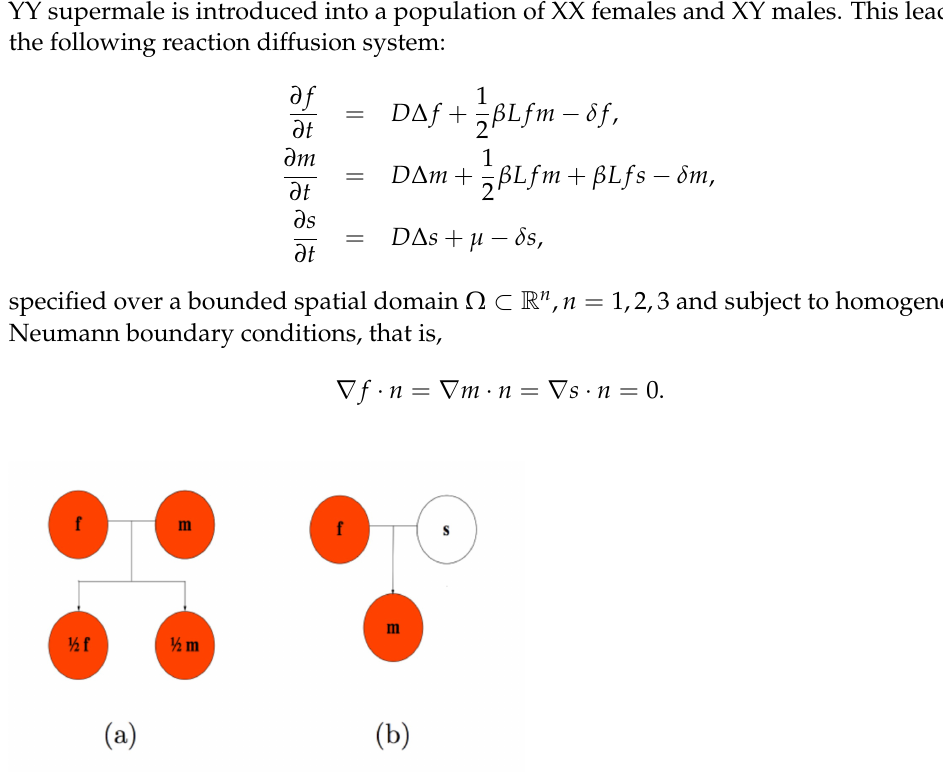
Figure 1. The pedigree tree of the TYC model (that demonstrates Trojan Y Chromosome eradication strategy). ( a ) Mating of a wild-type XX female (f) and a wild-type XY male (m). ( b ) Mating of a wild-type XX female (f) and a YY supermale